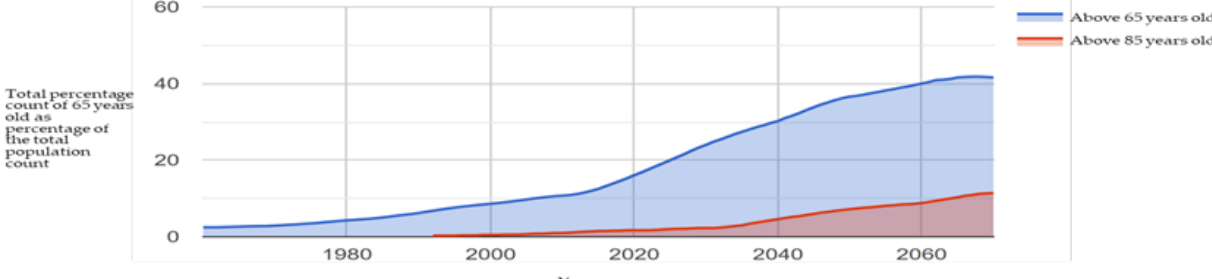
Figure 1. Percentage of those 65 years old to the total population in Taiwan; statistics from MOI 2022 and prepared by this study.